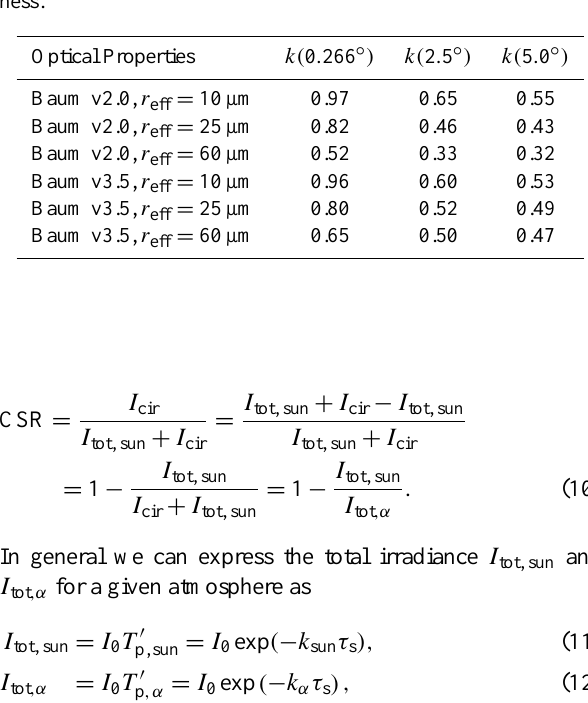
Table 1. Exemplary values of k (Eq. 7) for varying ice optical prop- erties. The listed k values translate a slant path optical thickness at 550nm into a broadband (430nm–2000nm) apparent optical thick-